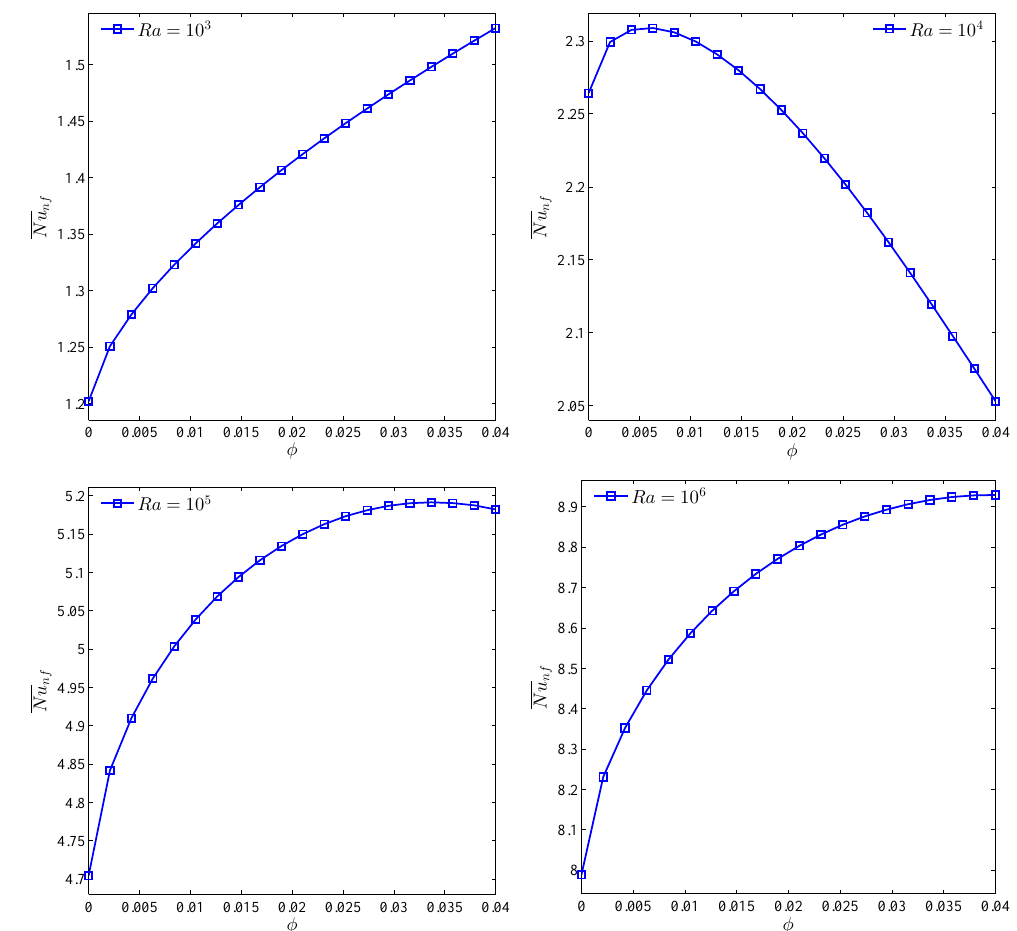
Figure 14. Variation of average Nusselt number with φ for different Ra at D = 0.3 and k w =